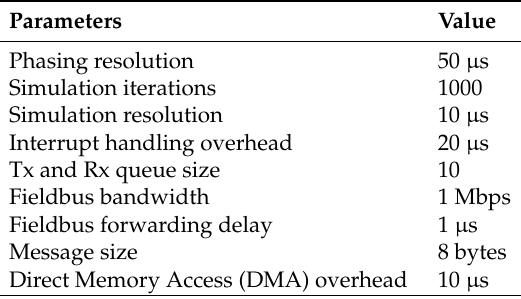
Table 2. Simulation